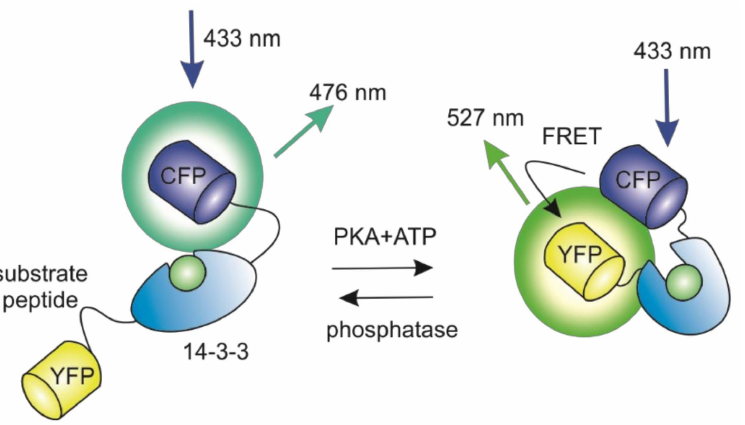
Figure 3. Schematic representation of ratiometric indicator for visualizing protein phosphorylation.